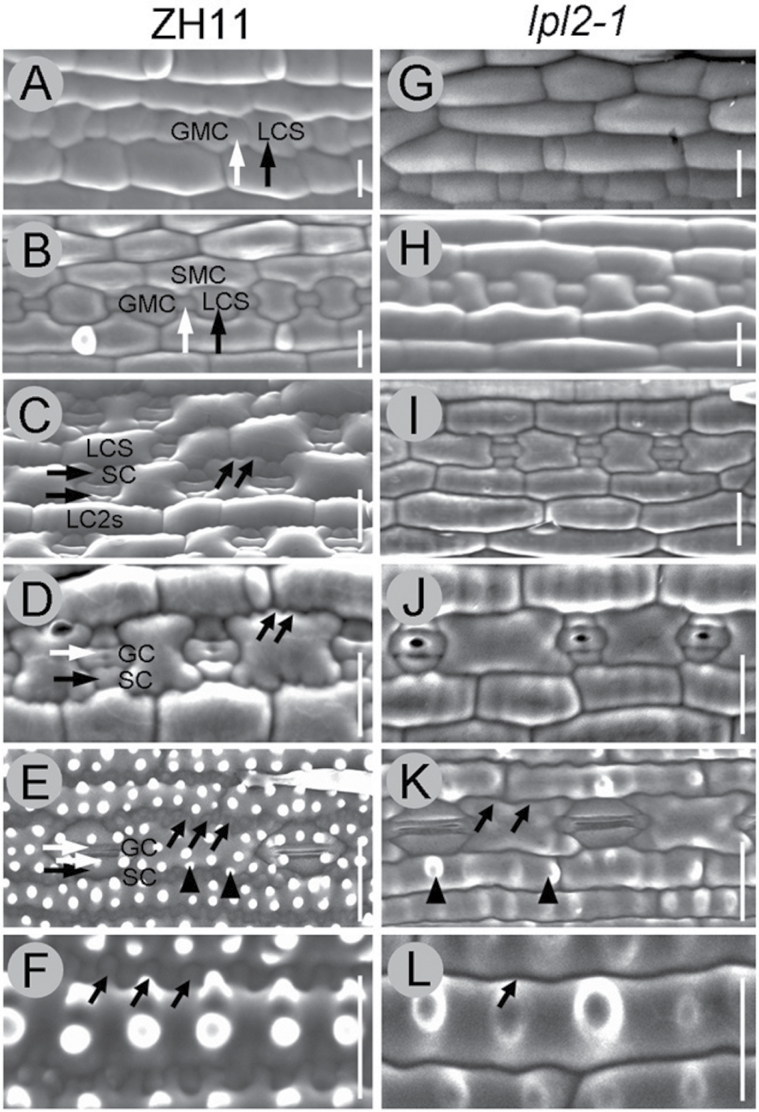
Morphogenic development of stomata and lobes in the abaxial leaf blade of rice. All images were continuously observed by SEM. (A–F) ZH11. (G–L) lpl2-1. (A, G) GMCs (vertical white arrow) and LCSs (vertical black arrow) were produced by the first asymmetric division. (B, H) SMCs initiated the second asymmetric division. (C, I) SCs (parallel black arrow) and LC2s or LCSs were generated by asymmetric divisions. One GMC and surrounding two SCs formed ‘three-cell complexes’, and lobes appeared (oblique black arrows) in ZH11 instead of lpl2-1 during this stage. (D, J) GCs (parallel white arrow) were produced by symmetrical division and PCs were further extruded. (E) Mature stomata and PCs with waved lobes were obviously observed and abundant papillae appeared in ZH11 (black arrowheads). (F) Amplified mature PCs with elongated and serrated lobes (oblique black arrows). (I–L) lpl2-1 showed epidermal PCs with gentler lobes (oblique black arrow) and decreased papilla (black arrowheads). Bars, 20 μm. LCSs, large long cells in stomata file; SMCs, subsidiary mother cells; LC2s, flanking stomata row long cells.